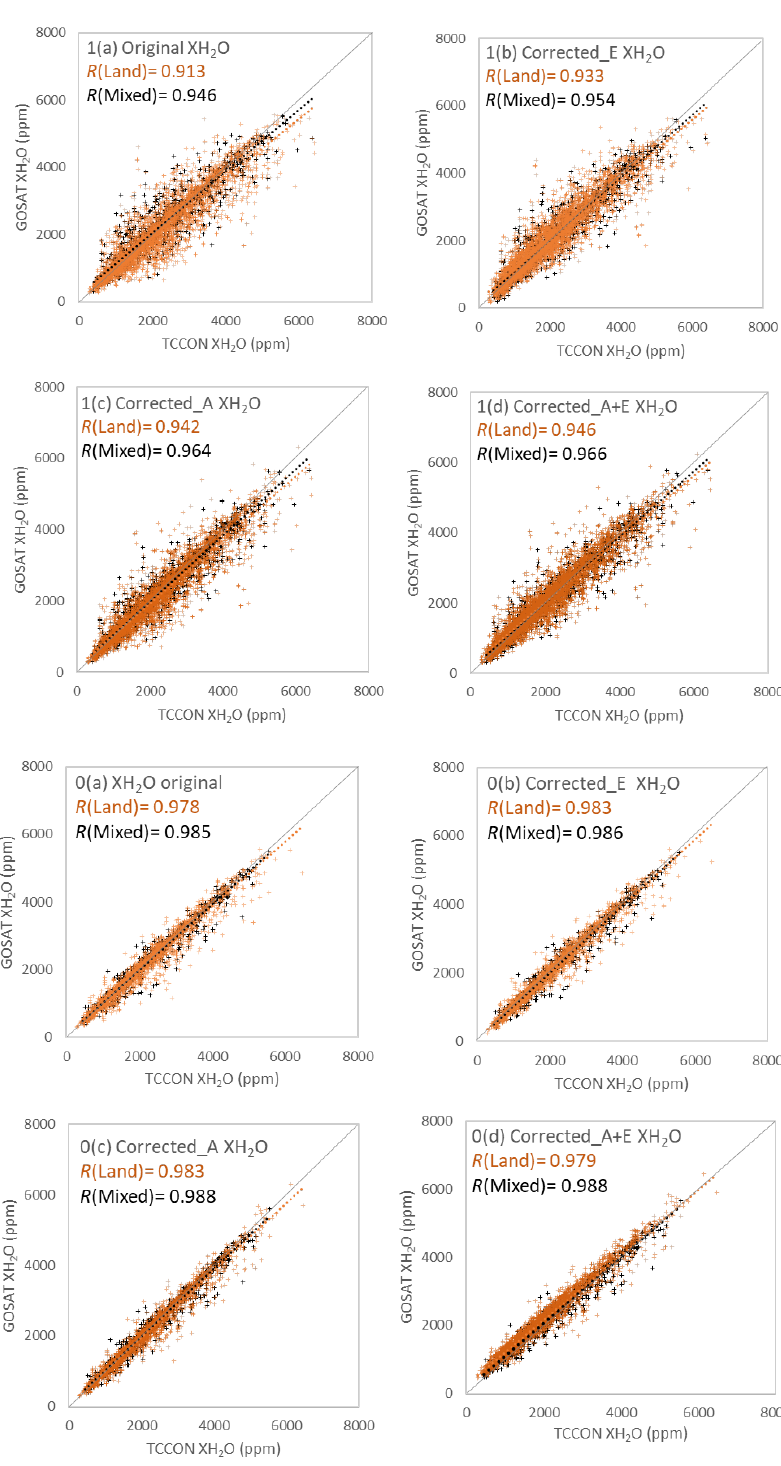
Figure 5. Correlations between GOSAT SWIR XH 2 O and TCCON XH 2 O for case 2 ( a – d ), case 1 ( a – d ), and case 0 ( a – d ). ( a ) Original GOSAT SWIR XH 2 O and TCCON XH 2 O, ( b ) GOSAT SWIR XH 2 O corrected by bias correction method (E) and TCCON XH 2 O, ( c ) GOSAT SWIR XH 2 O corrected by bias correction method (A) and TCCON XH 2 O, and ( d ) GOSAT SWIR XH 2 O corrected by bias correction method (A + E) and TCCON XH 2 O. Red symbols indicate GOSAT gain H land data and black symbols indicate GOSAT gain H mixed data. The dotted lines are the fitted regression lines and the solid lines show one-to-one correspondence.